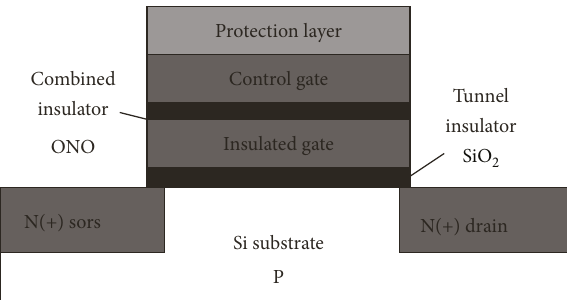
Figure 1: The structure of the memory cells with control (external) and insulated